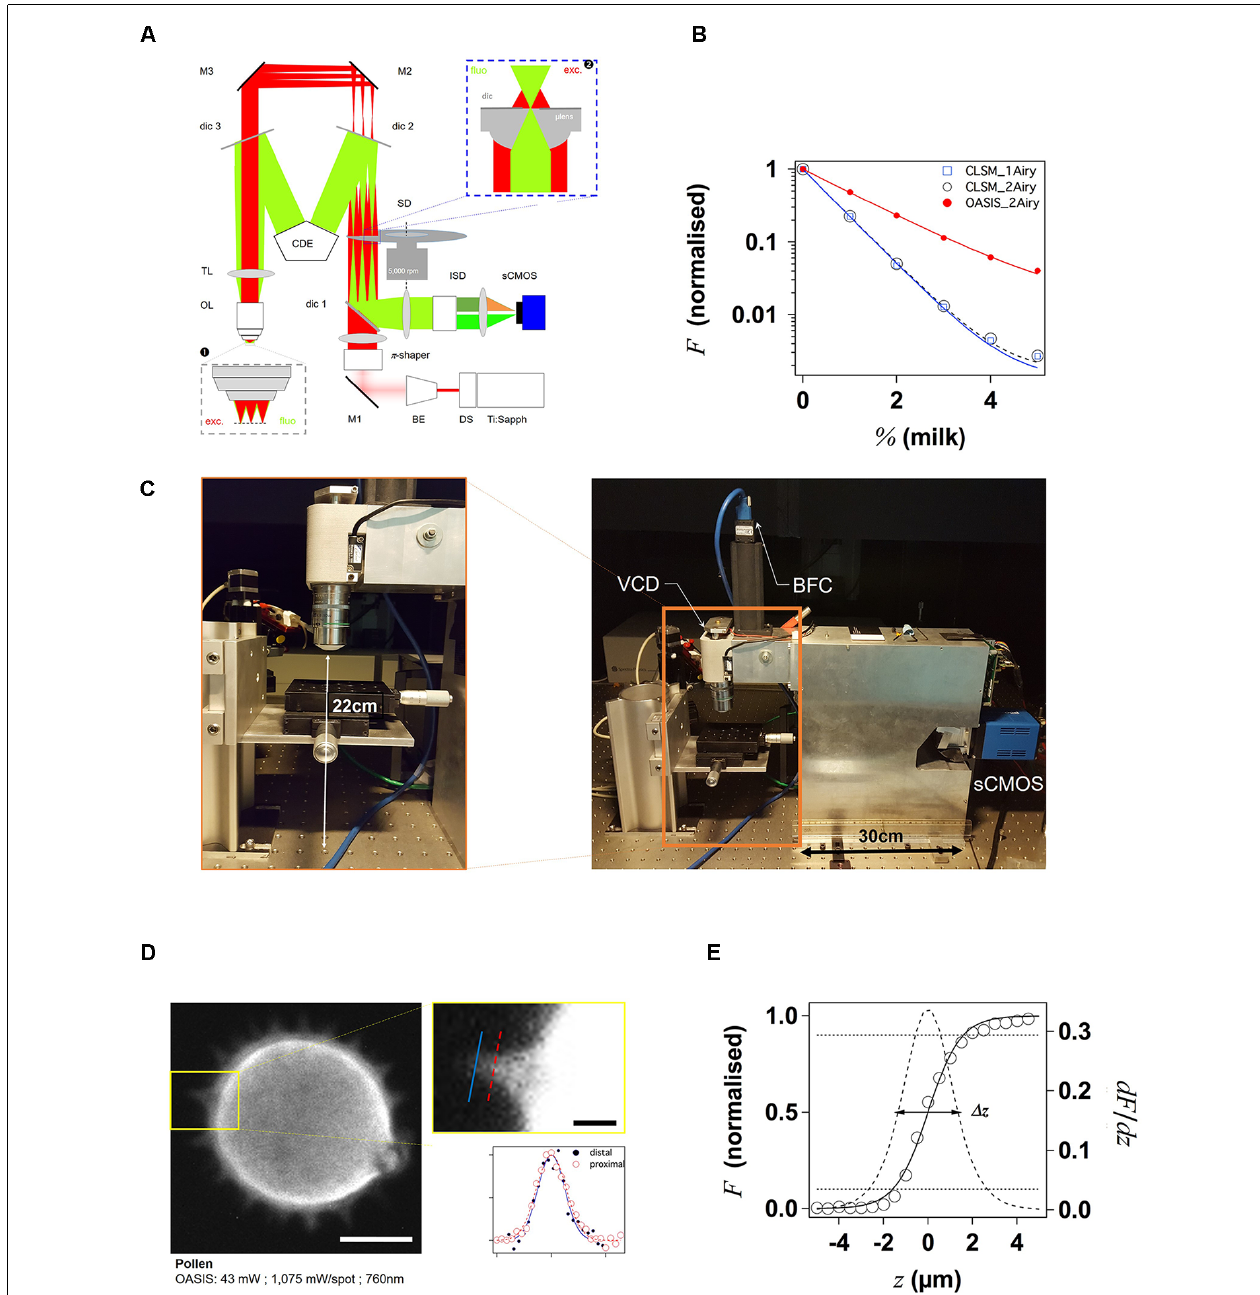
FIGURE 1 | Principle and performance of the On-axis 2-photon virtual light-sheet generation in vivo imaging system (OASIS). (A) Simplified optical path of our custom 2P microscope. Red : infrared (IR) excitation, green : fluorescence. Ti:Sapph, fs-pulsed IR laser; DS, DeepSee module (pulse stretcher); BE, beam expander; π -shaper, optical element that converts the Gaussian beam into a top hat profile; M, mirrors; dic, dichroic mirrors; SD, spinning disk; TL, tube lens; CDE, corrective • distance element; OL, objective lens; ISD, image-splitting device; sCMOS, camera. Inset 1 : (simplified) multi-spot excitation pattern and epi-collection of the • generated fluorescence through the same objective. Inset 2 : detail of microlens/pinhole/dichroic coating arrangement. Note the offset between the excitation (exc.) and fluorescence foci (fluo.) at the level of the disk, produced by the CDE. (B) Measured depth penetration in turbid samples. Log-plot of 2P-excited fluorescence from a green-fluorescent Chroma test slide, topped either with water (0%) or increasing concentrations of milk (a model for the multi-scale scatterers present in tissue), for the OASIS (red dots) and a ZEISS LSM710. Confocal pinhole diameters were 1 and 2 Airy, as indicated. (C) OASIS prototype, note the compact size and space available around the objective, inset . VCD, voice coil z -drive; BFC, bright-field camera. (D) Assessment of OASIS lateral resolution. Equatorial section through an autofluorescent thorny pollen grain. Scale bar, 10 µ m. Inset : magnified view of an in-focus spine and intensity profiles across the lines shown; Scale bar, 2 µ m. (E) OASIS z- resolution. Axial-intensity profile measured from a z -stack of images acquired from a green fluorescent Chroma slide (solid line), and its derivative dF / dz (dashed). The 10%–90% intensity range was taken as axial optical sectioning capacity (cid:49) z .